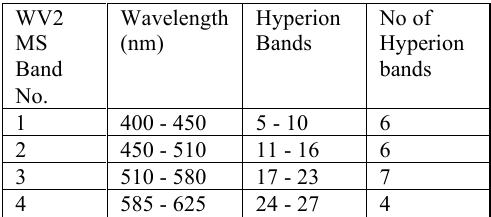
Table1: Spectral Correspondence between Hyperion